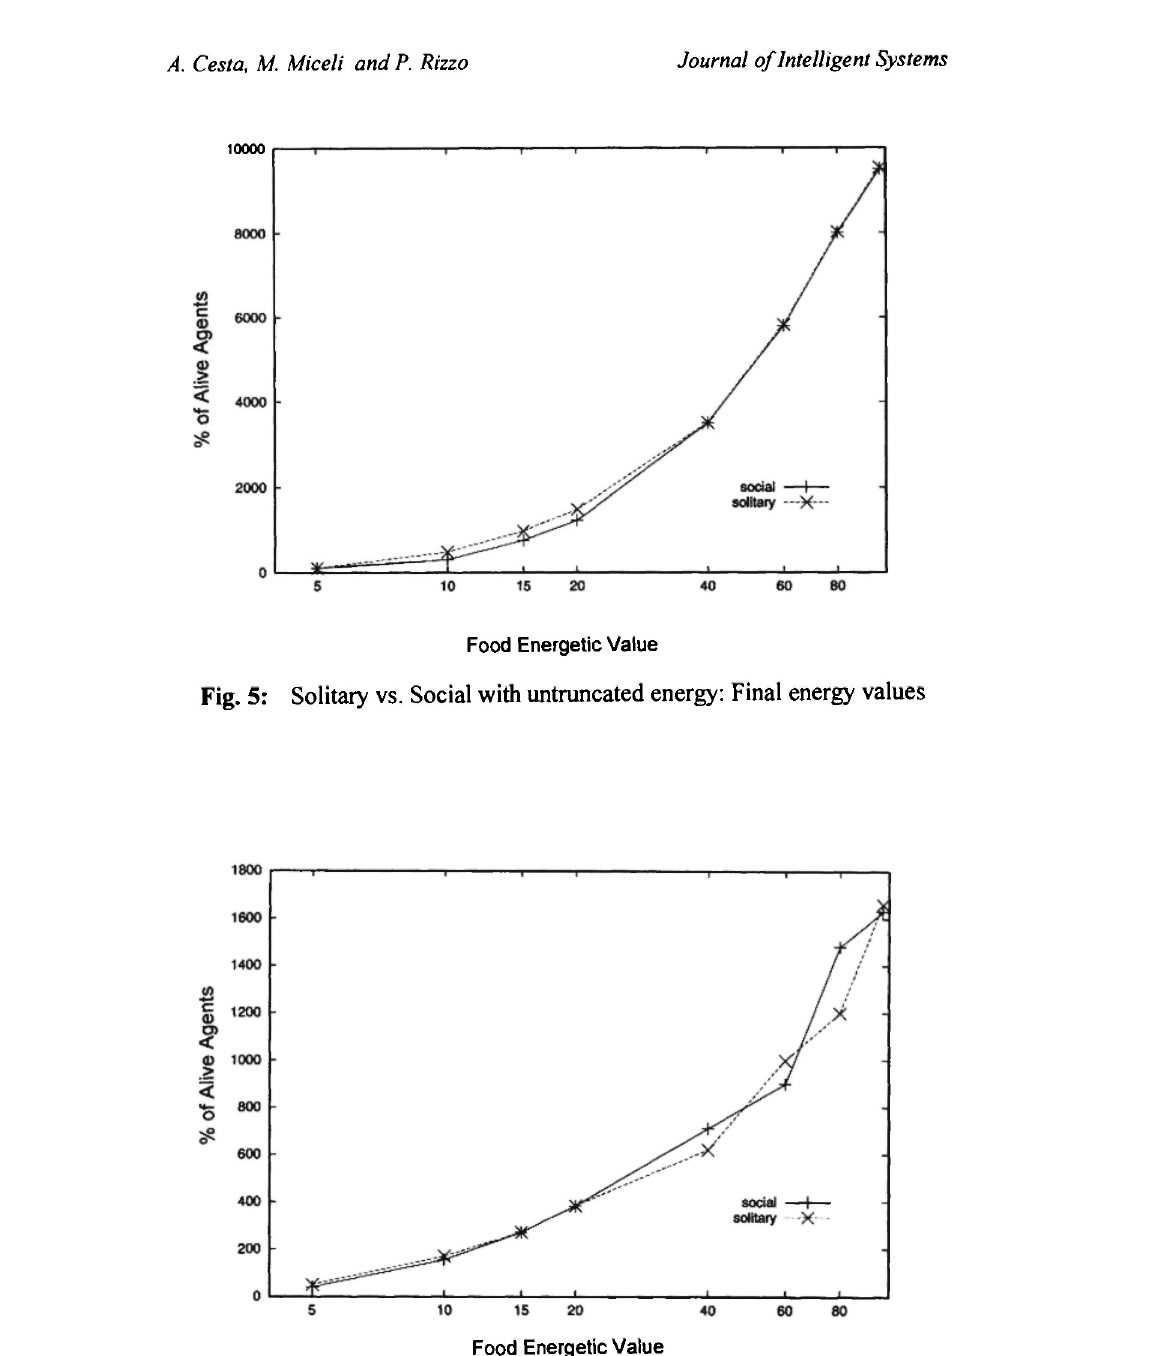
Food Energetic Value Fig. 6: Solitary vs. Social with untruncated energy: SDs in energy values